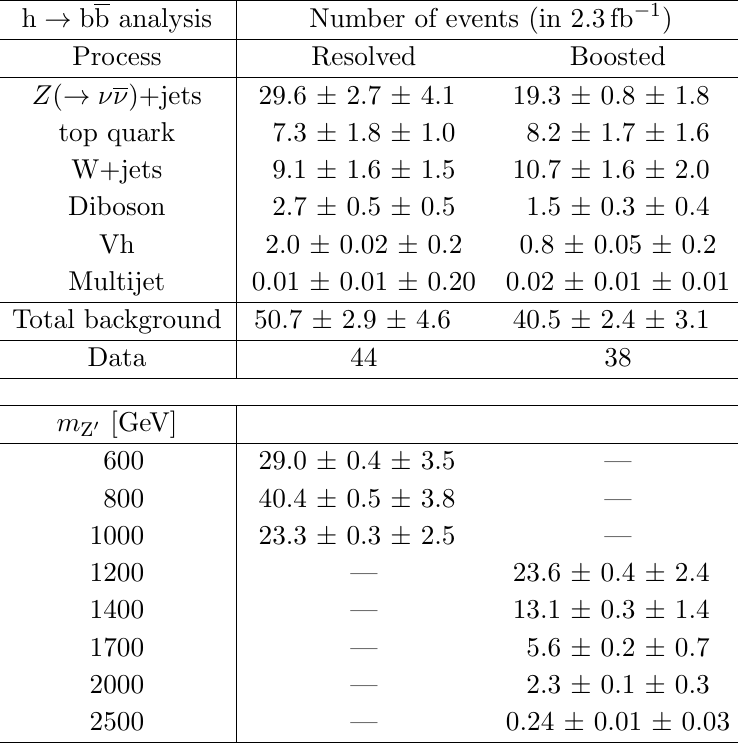
Table 2 . Post-(cid:12)t background event yields and observed numbers of events in data for 2.3 fb (cid:0) 1 in both the resolved and the boosted regimes for the h ! bb analysis. The expected numbers of signal events for m A = 300 GeV, scaled to the nominal cross section with g Z 0 = 0 : 8, are also reported. The statistical and systematic uncertainties are shown separately in that